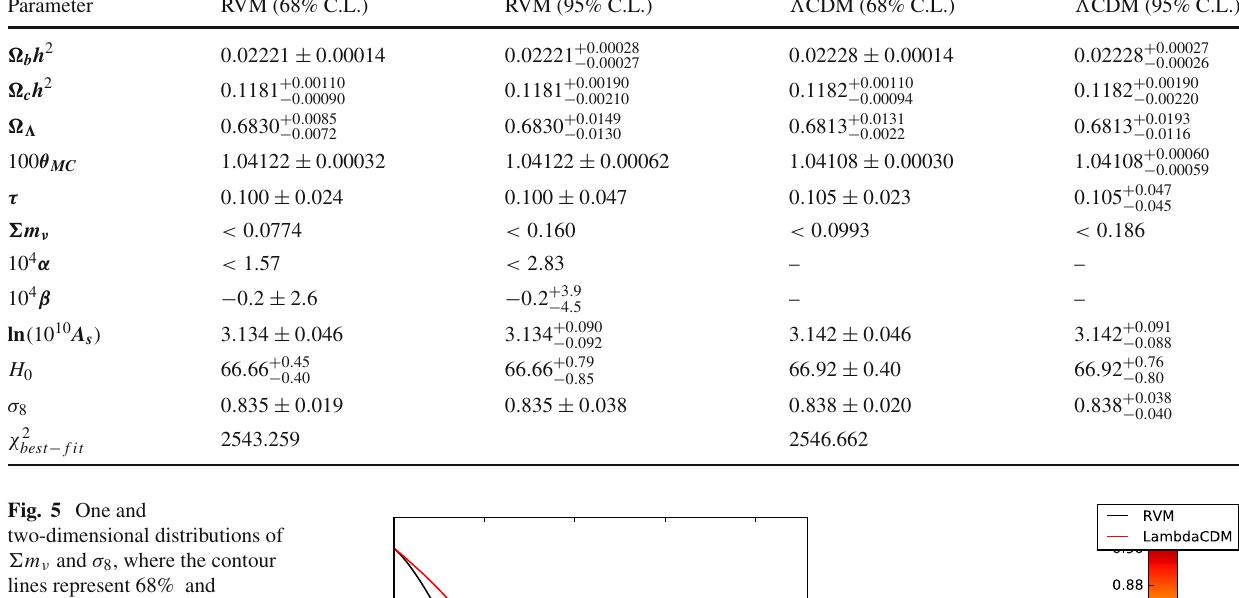
Fig. 5 One and two-dimensional distributions of (cid:6) m ν and σ 8 , where the contour lines represent 68% and 95% C.L.,